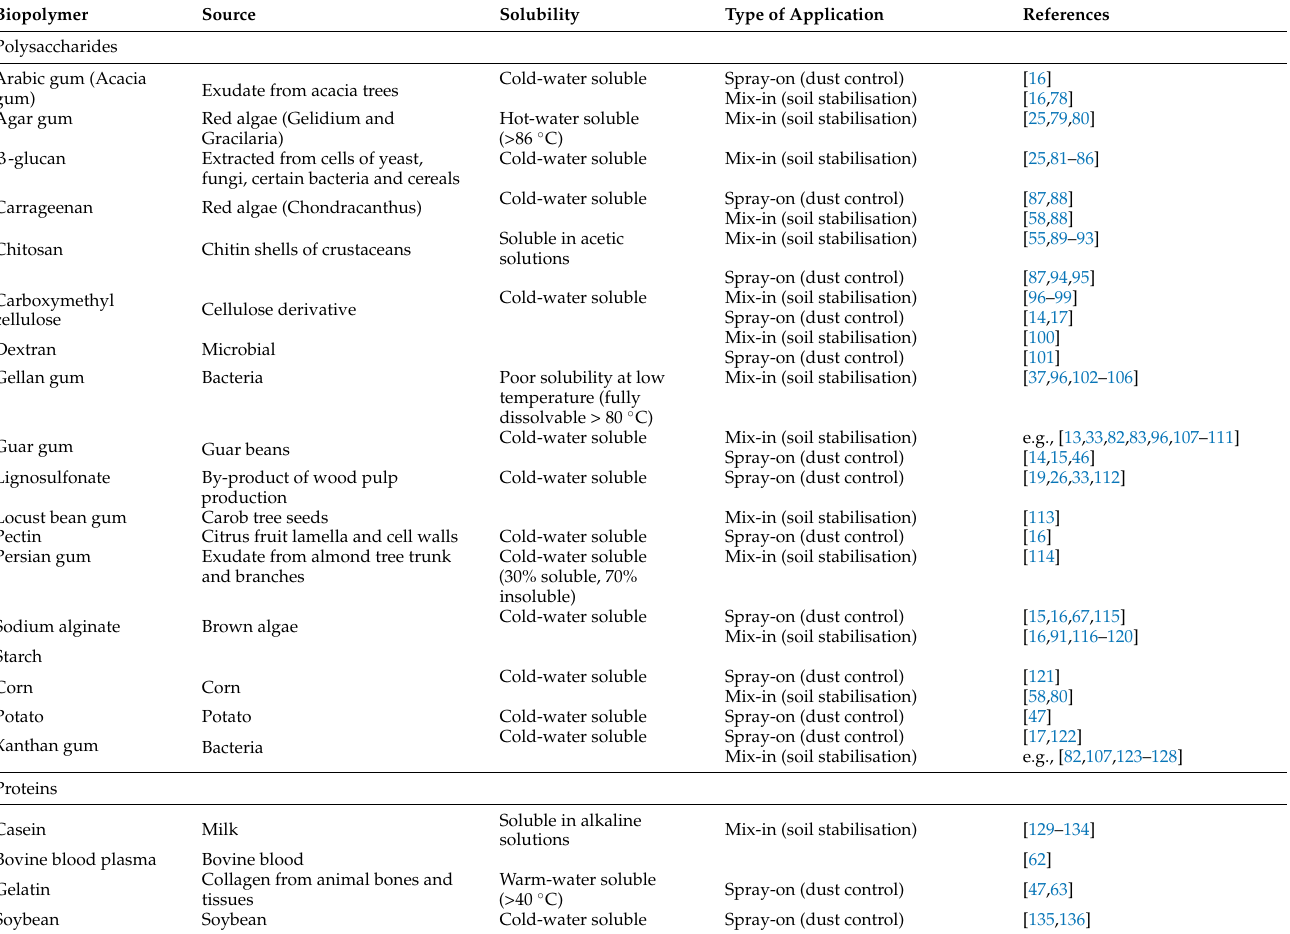
Table A1. Compilation of previous studies investigating biopolymer applications in the disciplines of soil stabilisation and dust